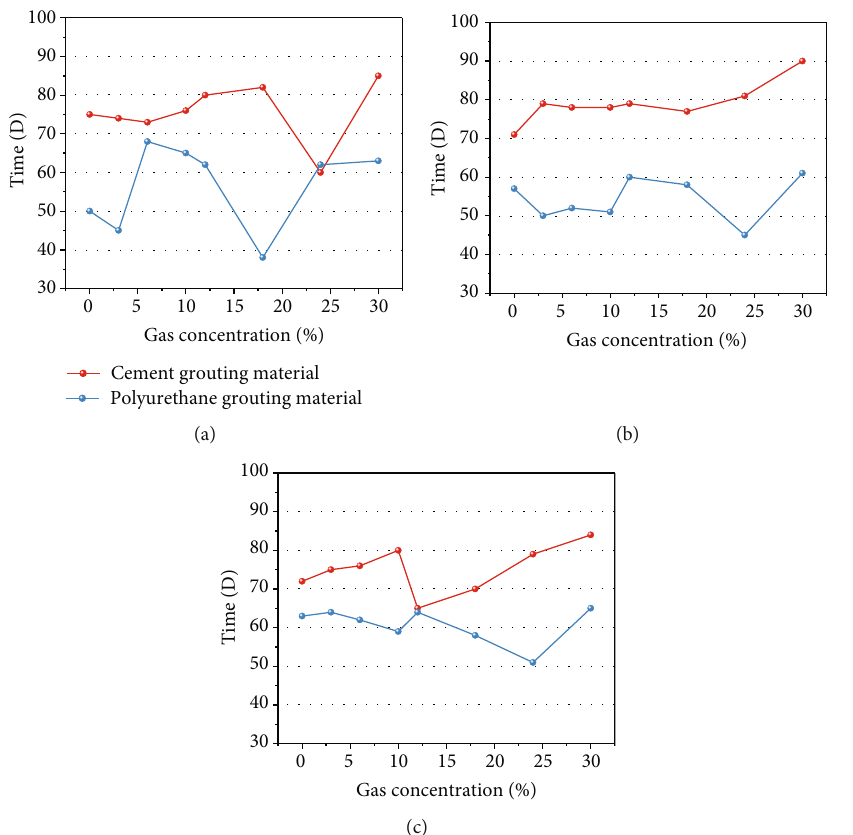
Figure 22: (a) The fi rst group, (b) the second group, and (c) the third group: the comparison of the average concentration of gas